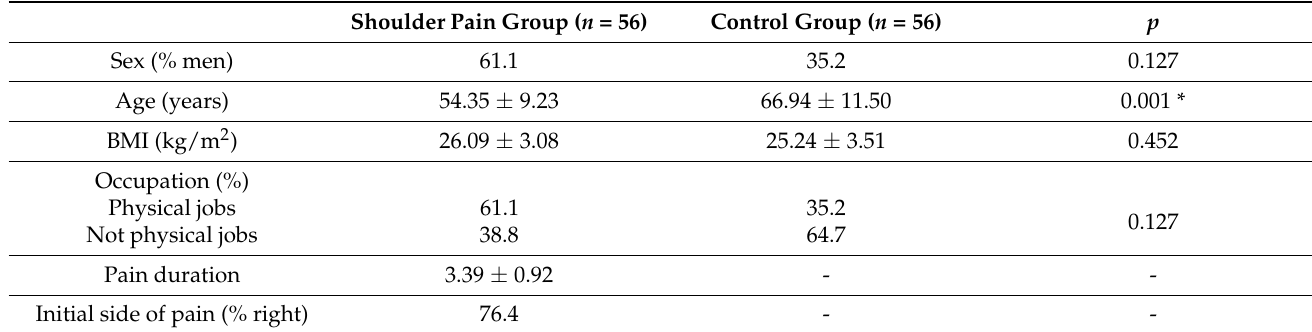
Table 1. Demographic and pain characteristics of the